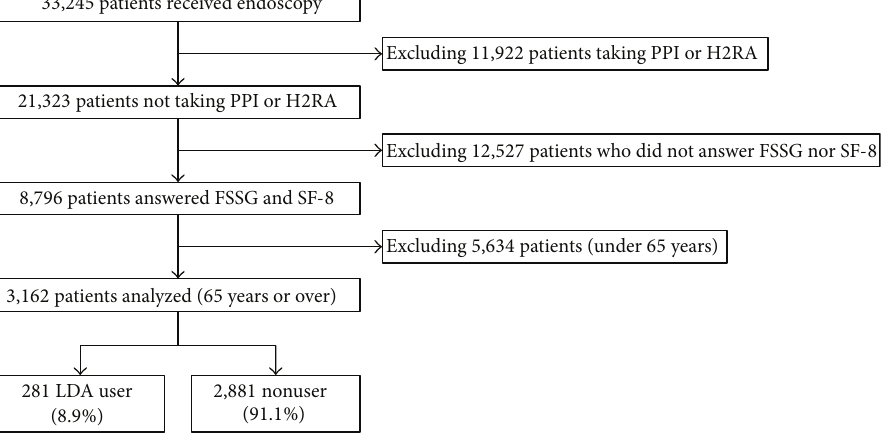
Figure 1: Flow chart of the study patients. PPI = proton pump inhibitor, H2RA = histamine-2 receptor antagonist, FSSG = Frequency Scale for Symptoms of GERD, and SF-8 = Short-Form 8 Health